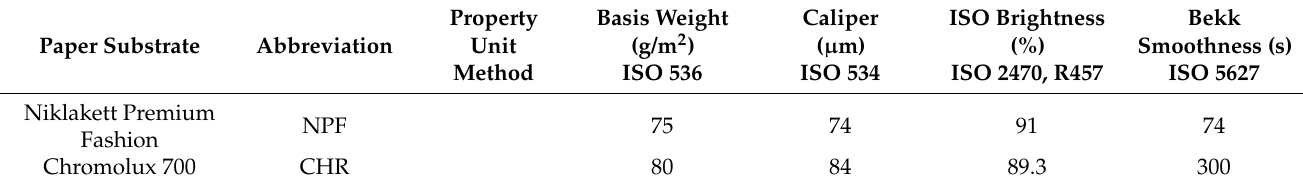
Table 1. Properties of used printing substrates.